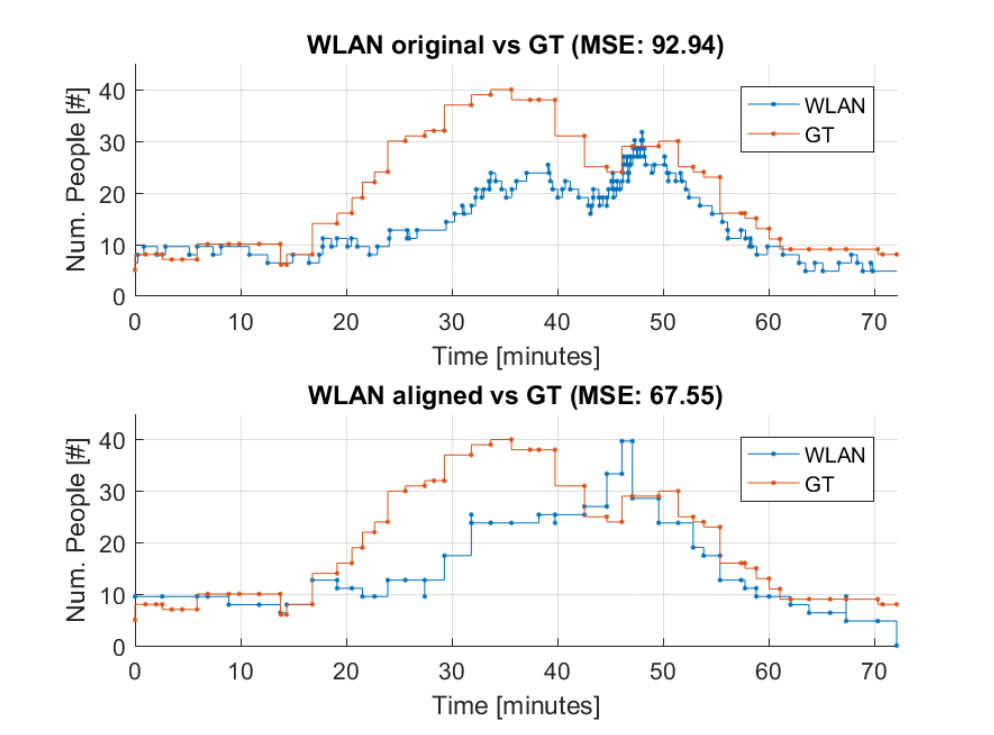
Figure 3. Comparison of WLAN estimator and GT before and after the alignment of the WLAN estimator based on dataset 3